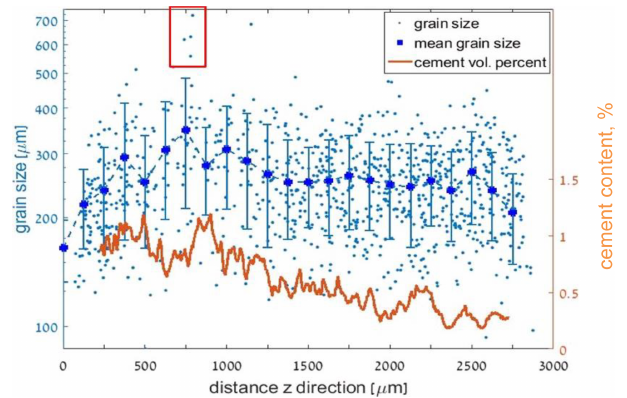
Figure 17. Grain size scattering and FeOx cement content in sand- stone S1 in slices along the z direction. The red rectangle empha- sizes very large grains that were